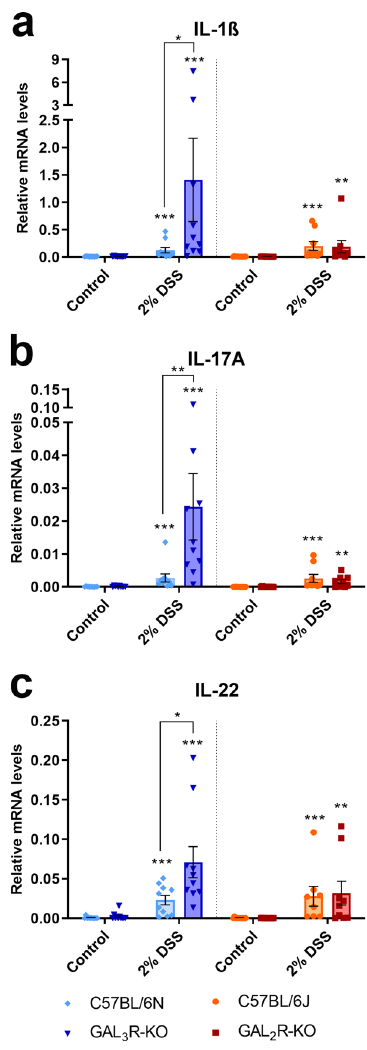
Figure 6. Relative mRNA expression levels of IL-1β ( A ), IL-17A ( B ) and IL-22 ( C ) in the colon of GAL 3 R-KO, GAL 2 R-KO and corresponding WT mice. Levels were determined relative to the housekeeping gene HPRT. Data represent means ± SEM. n = 7–11. Data were analyzed by Kruskal–Wallis test followed by Mann–Whitney U test. * p < 0.05; ** p < 0.01; *** p < 0.001 versus corresponding controls or as